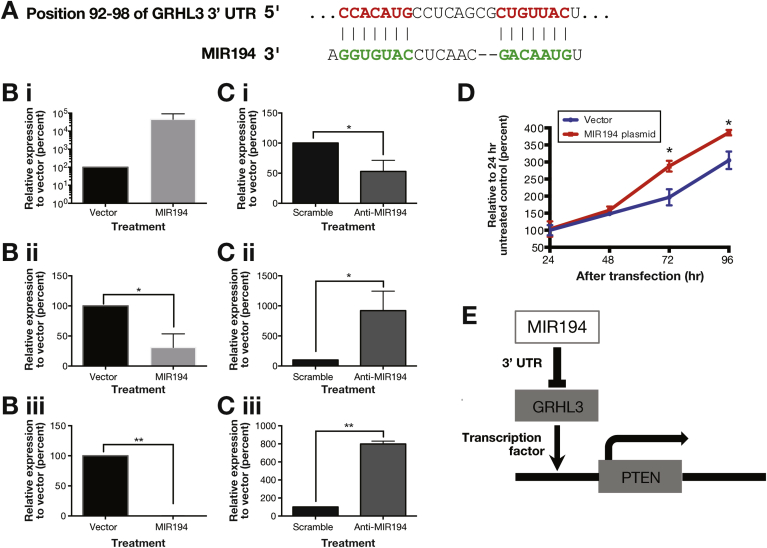
Dysregulated MIR194 expression drove cell proliferation in vitro through MIR194-GRHL3-PTEN axis. (A) Genomic alignment of GRHL3 mRNA 3′ UTR with MIR194. Normal esophageal cell line NES were transfected with either MIR194 plasmid (B) or anti-MIR194 (C). Relative expression of MIR194 (i), GRHL3 (ii), and PTEN (iii) in NES cell line was examined by qPCR Error bars show standard deviation of the mean: *P < .05; **P < .01. (D) Cell growth was determined by trypan blue exclusion assays every 24 hours for a period of 96 hours after MIR194 transfection relative to vector control. Error bars show standard deviation of the mean: *P < .05. (E) Diagram shows MIR194-GRHL3-PTEN cascade network.